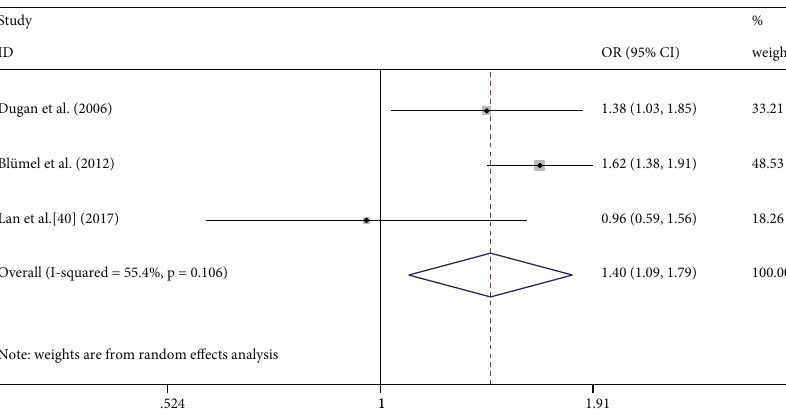
Figure 6: Meta-analysis of moderate/severe MSP between premenopausal and perimenopausal women. Three studies were included in the analysis. OR (95% CI): odds ratio (95% con fi dence interval).